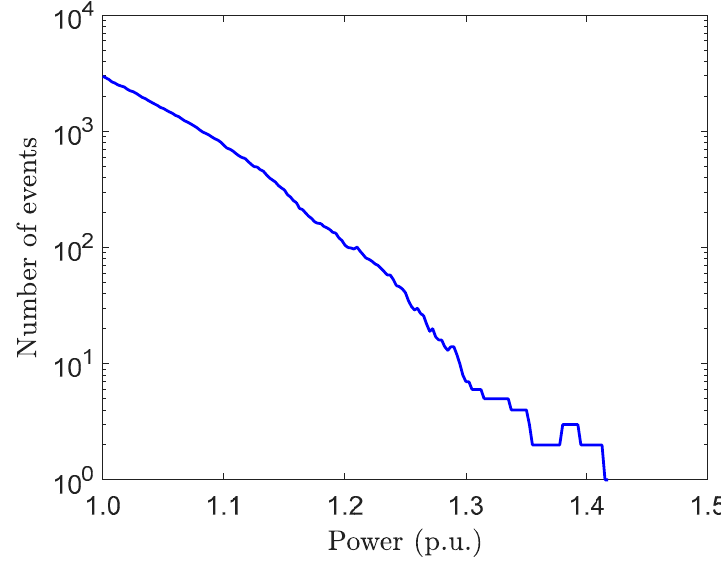
Figure 7. The number of overpower events as a function of power during the observation period when the power of the PV generator exceeds that power value.